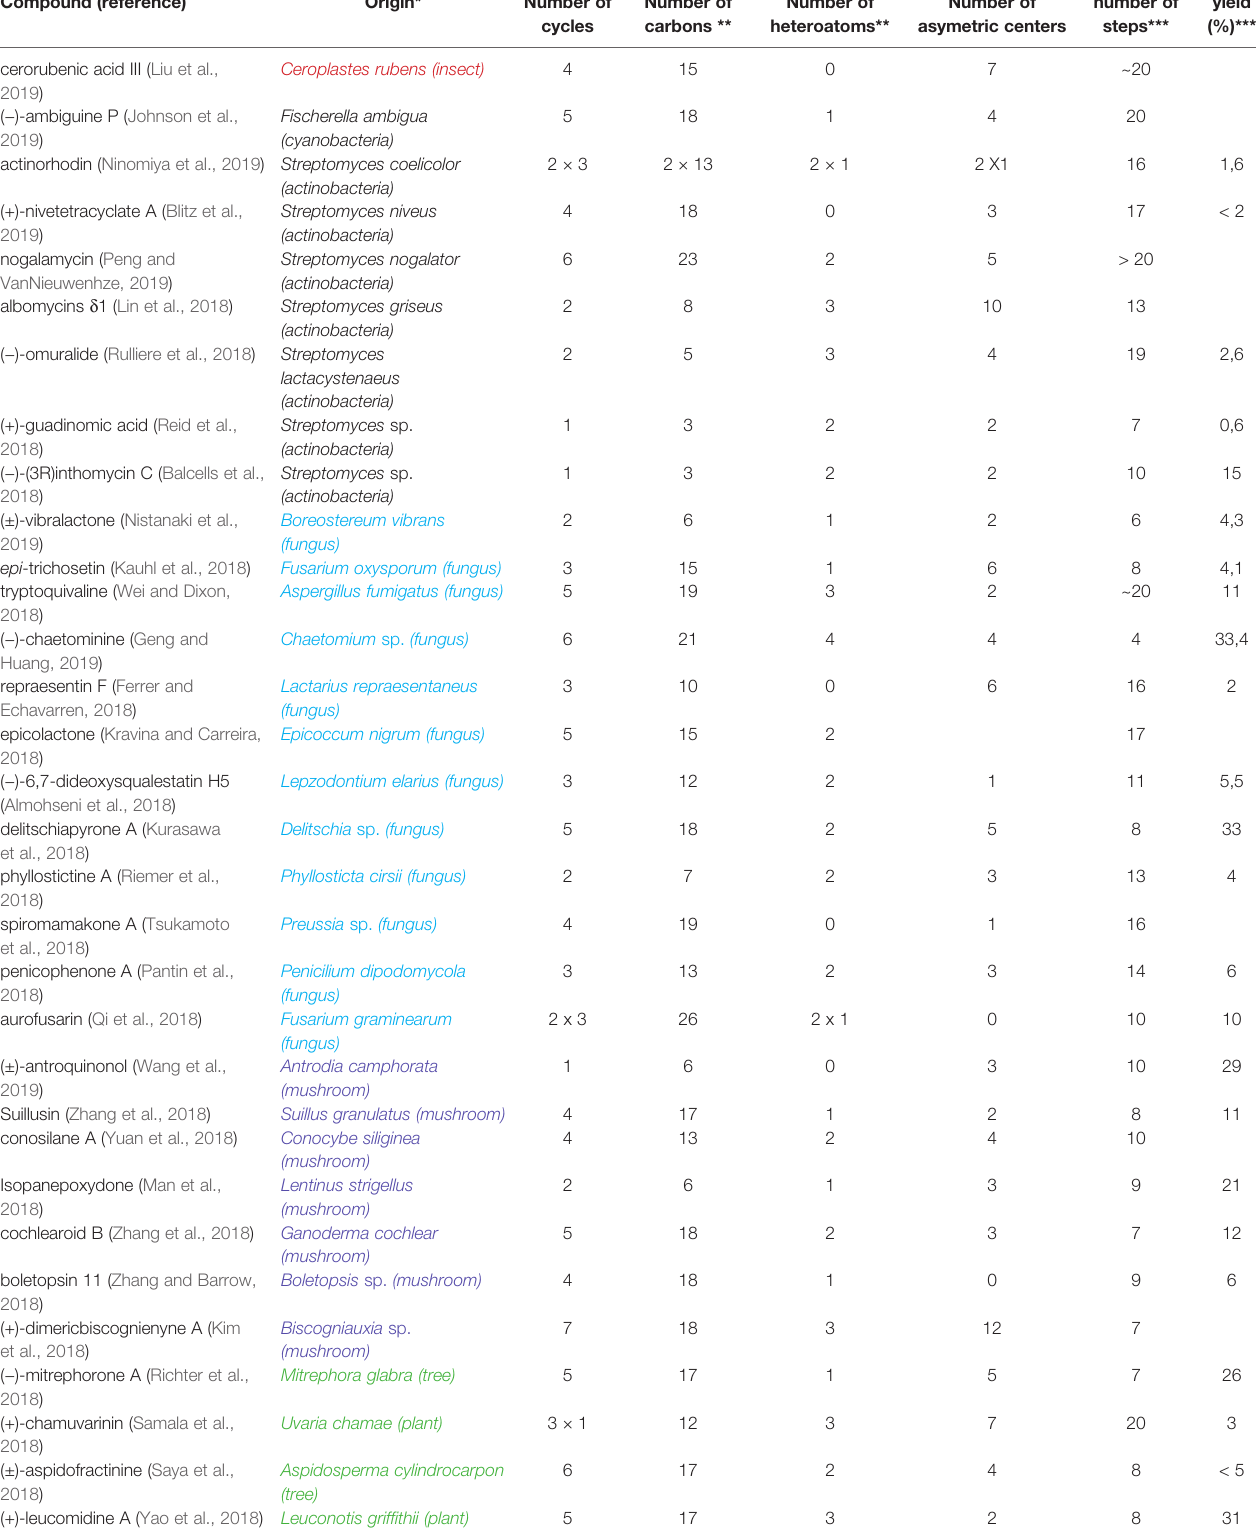
TABLE 6 | Some examples of total synthesis of natural